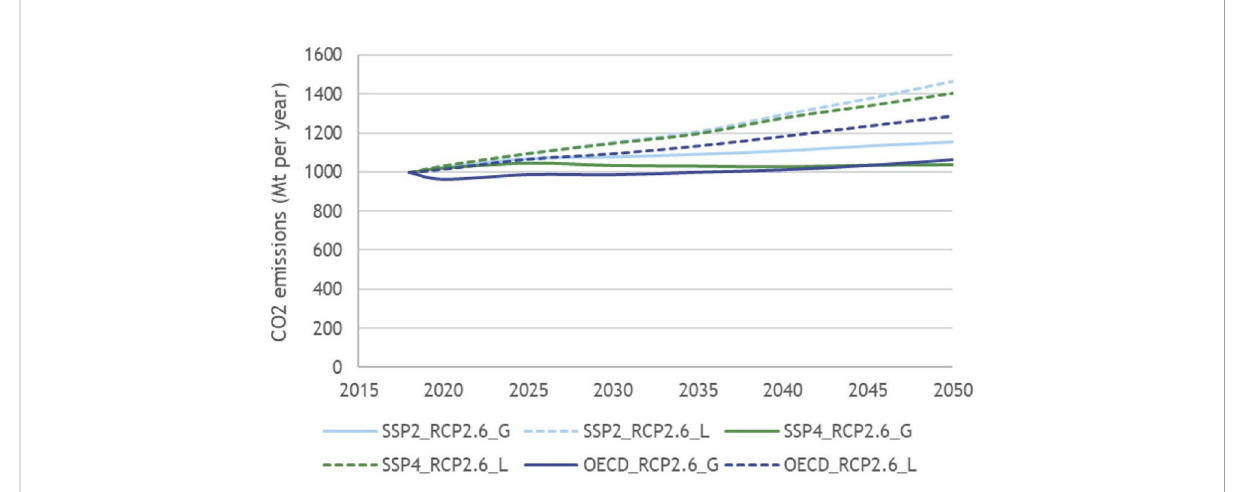
FIGURE 1 BAU forecasts of CO 2 emissions from ships under different scenarios. Source: IMO Fourth GHG Study (IMO,